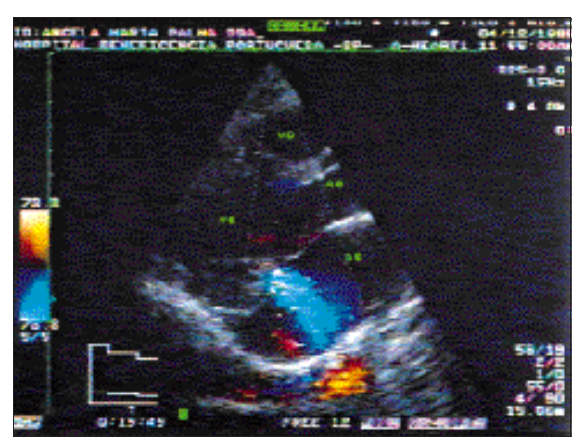
Fig. 2 – Ecocardiograma transtorácico. Corte paraesternal esquerdo longitudinal com mapeamento de fluxo em cores mostrando regurgitação mitral importante.